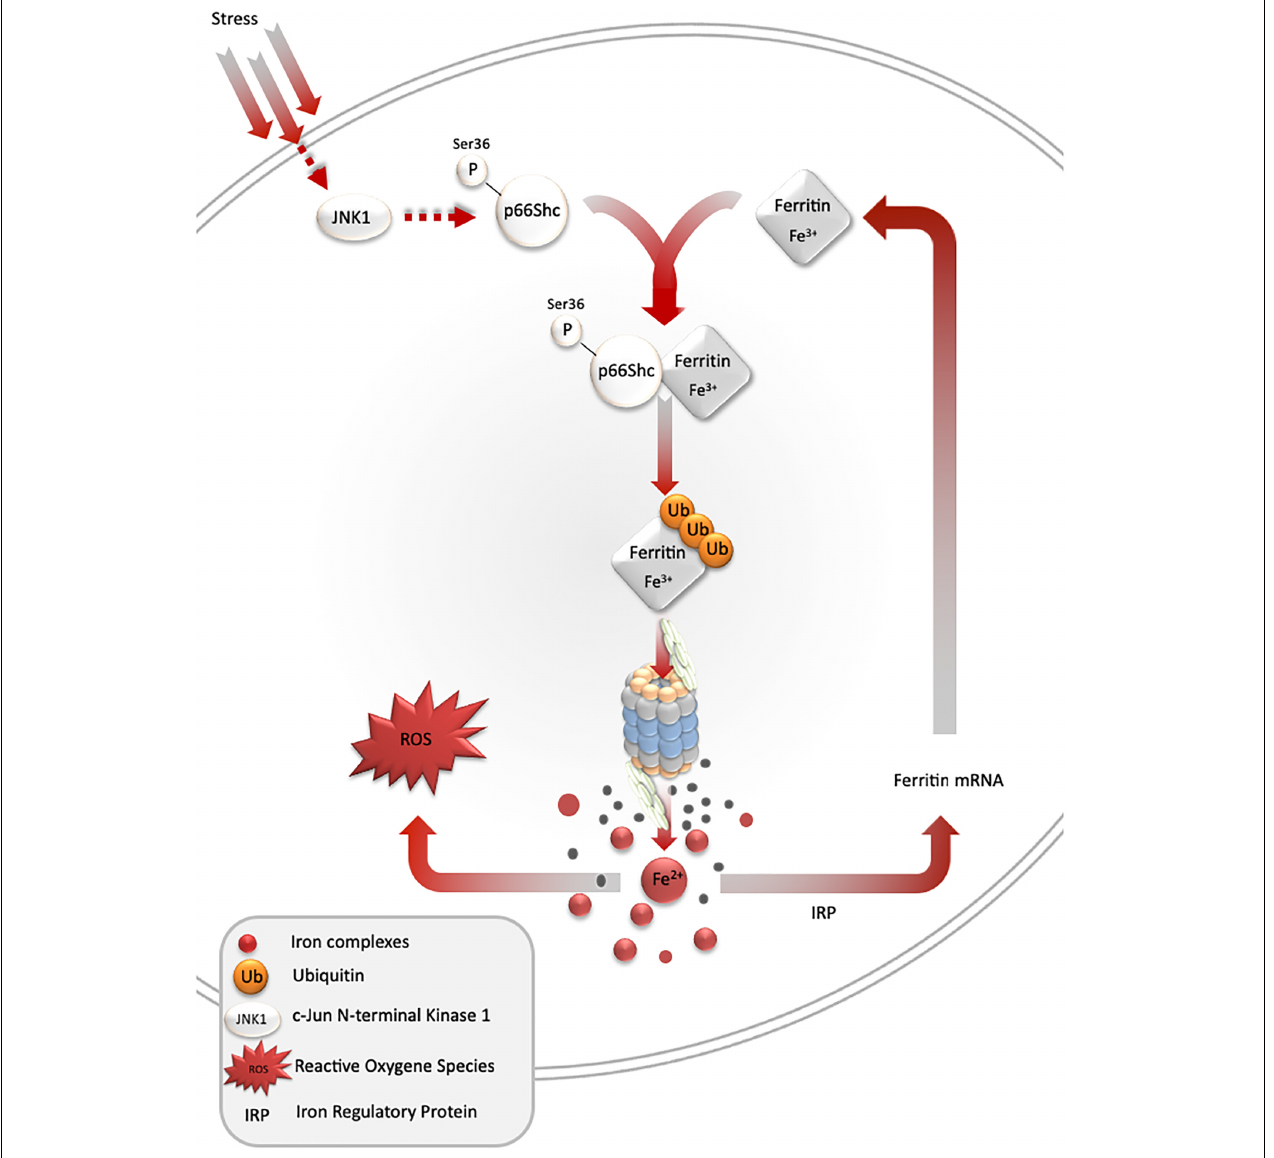
FIGURE 2 | Stress-mediated ferritin degradation leads to increase in iron-dependent ROS formation. Overexpression of SOD1 G93A leads to JNK and p66Shc activation, ferritin ubiquitination, and degradation by proteasome. As a result, LIP and iron-dependent ROS formation increase. In addition, iron augments ferritin synthesis in order to overcome iron